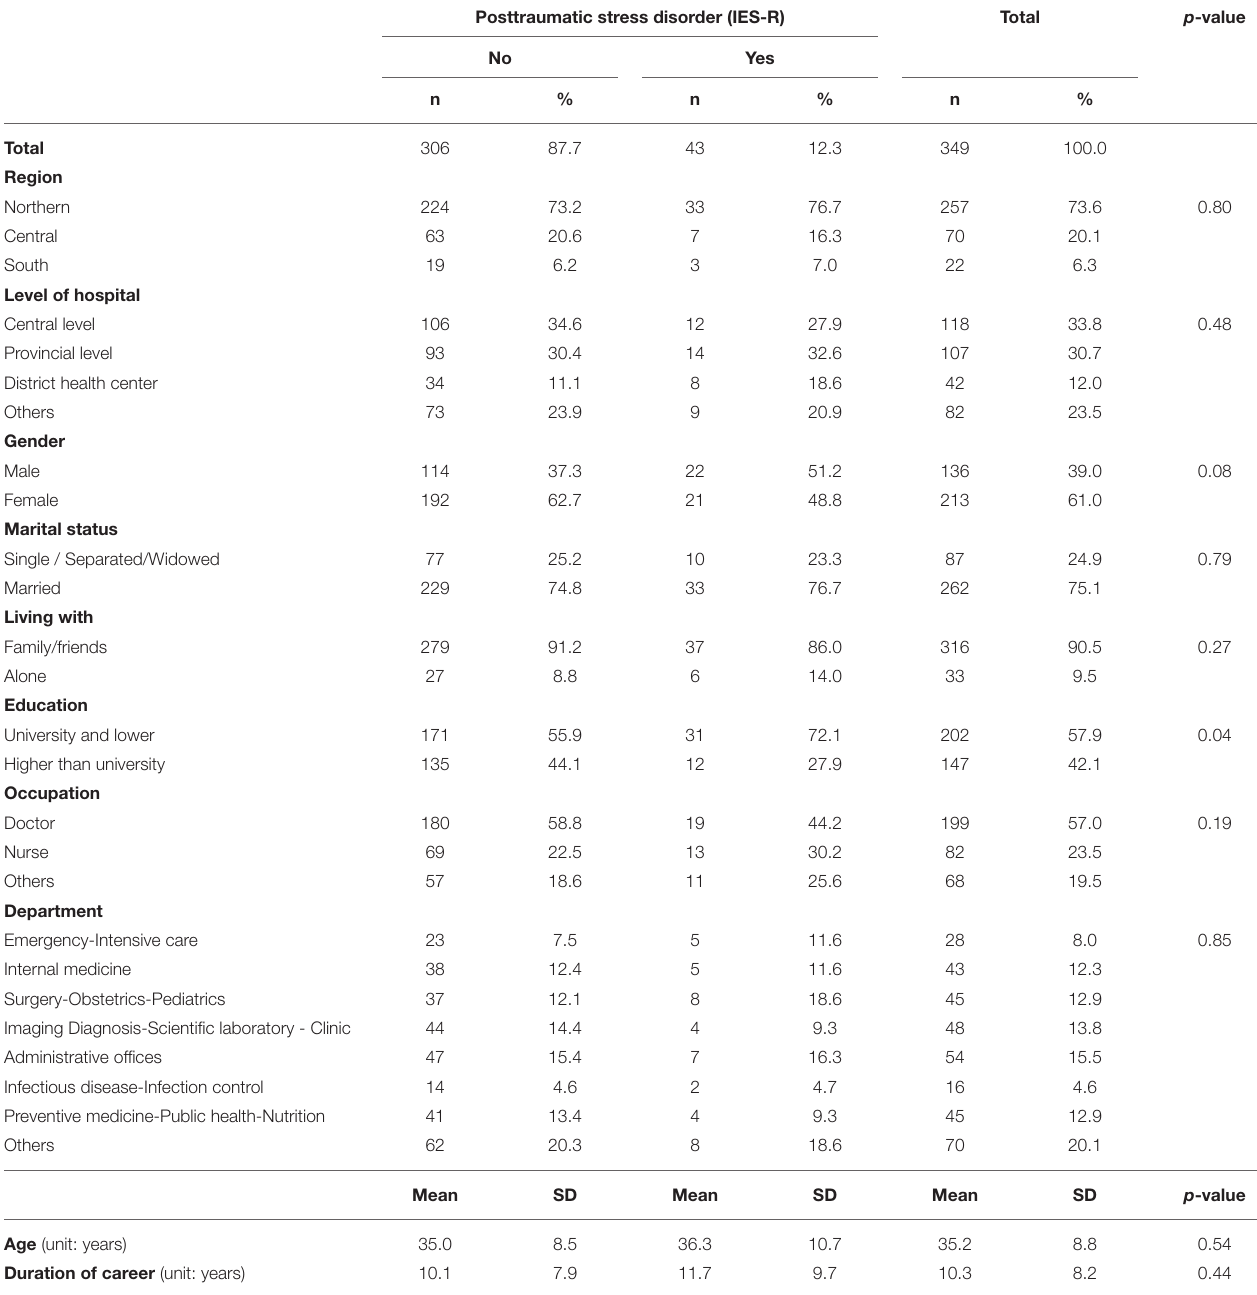
TABLE 1 | Socioeconomics characteristics of participants. Posttraumatic stress disorder (IES-R)